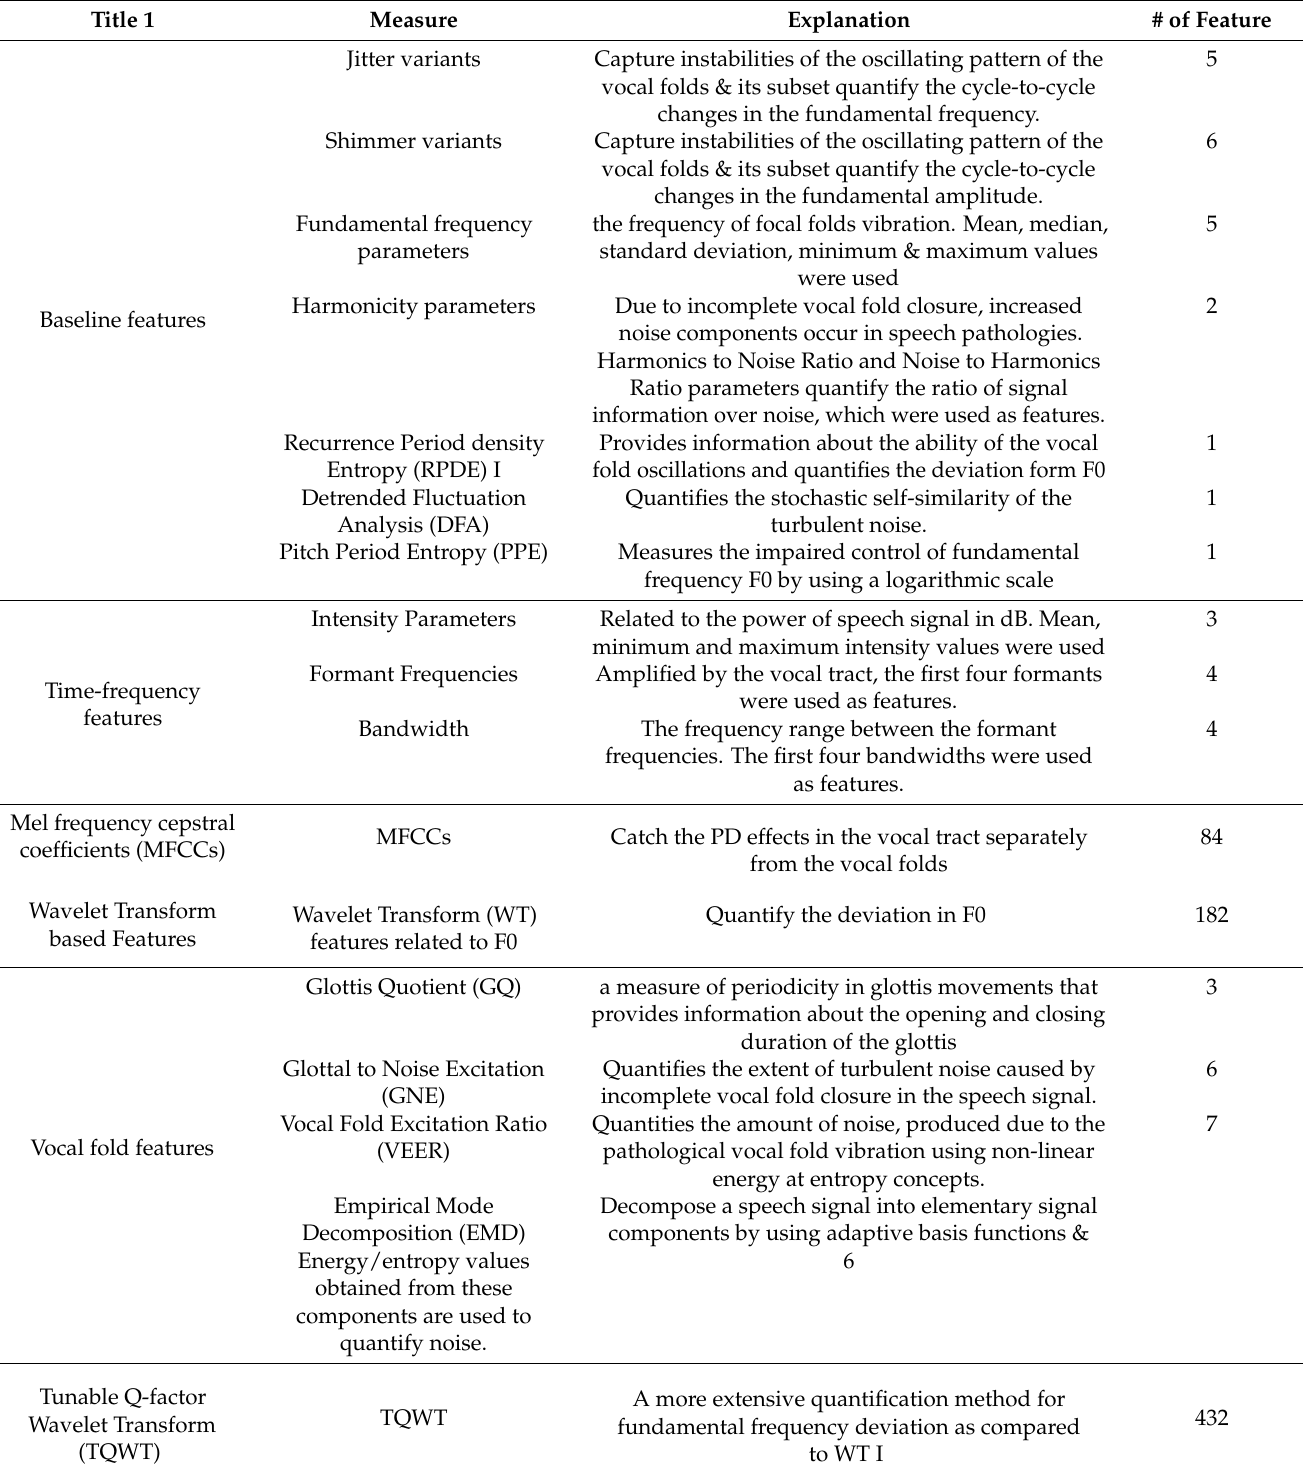
Table 1. Overview of the feature